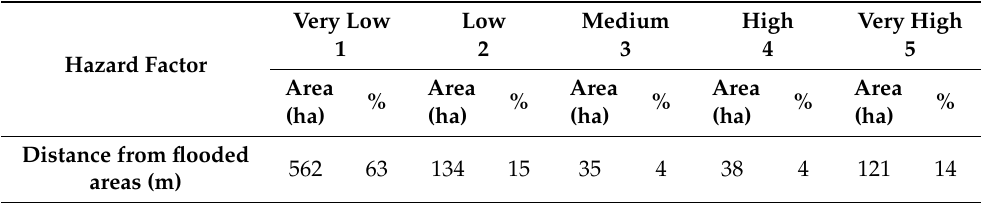
Table 19. Areas and percentages of the study area classified as each class of the distance from flooded areas hazard